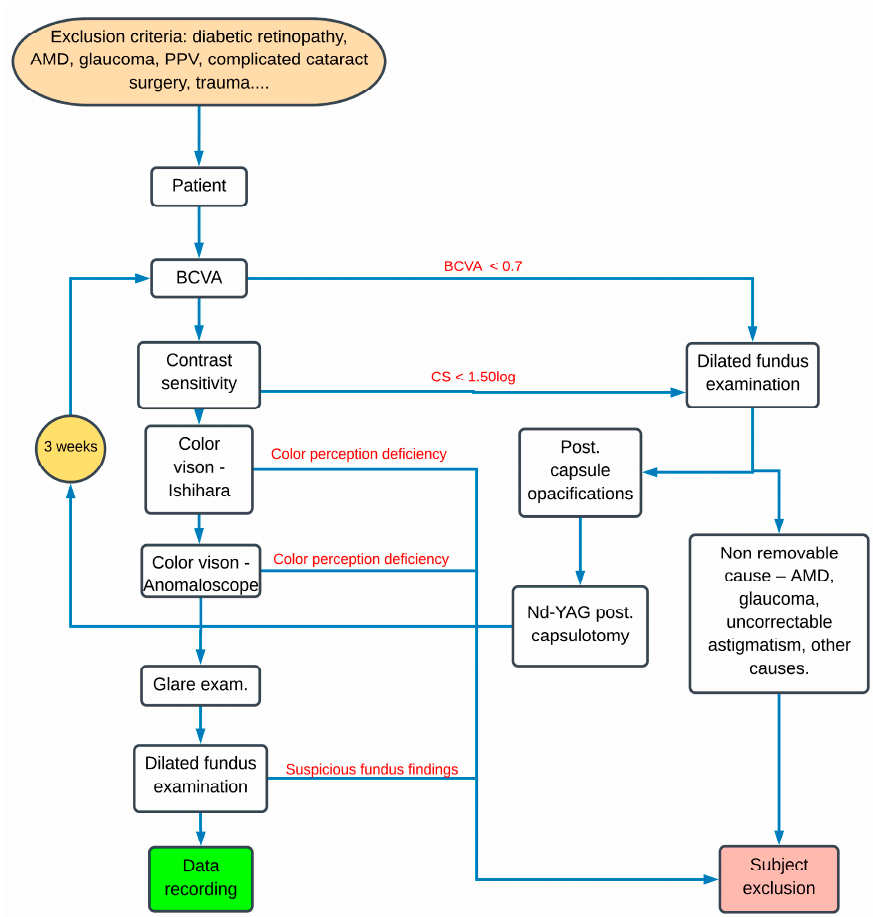
Figure 1. Algorithm of the examination. BCVA—Best Corrected Visual Acuity; CS—Contrast Sensitivity; PPV—Pars Plana Vitrectomy; AMD—Age-related Macular Degeneration.